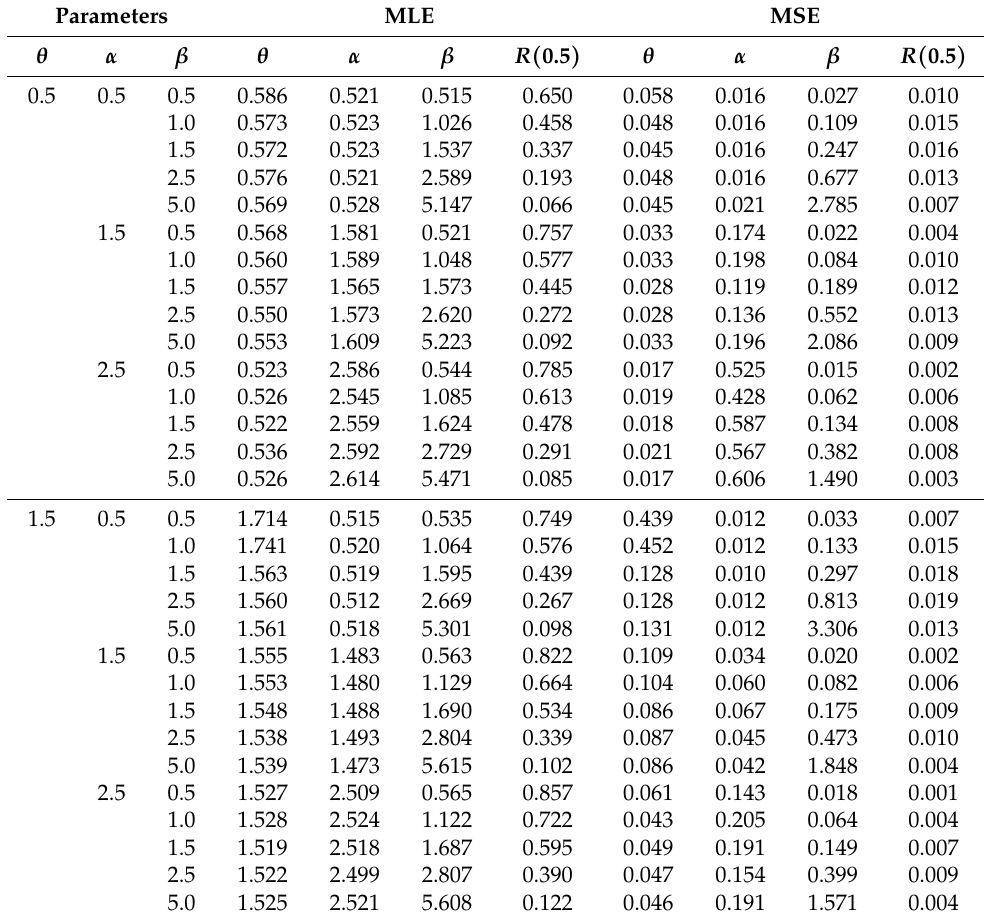
Table 3. The AVs of estimates and the corresponding MSEs for n = 25.